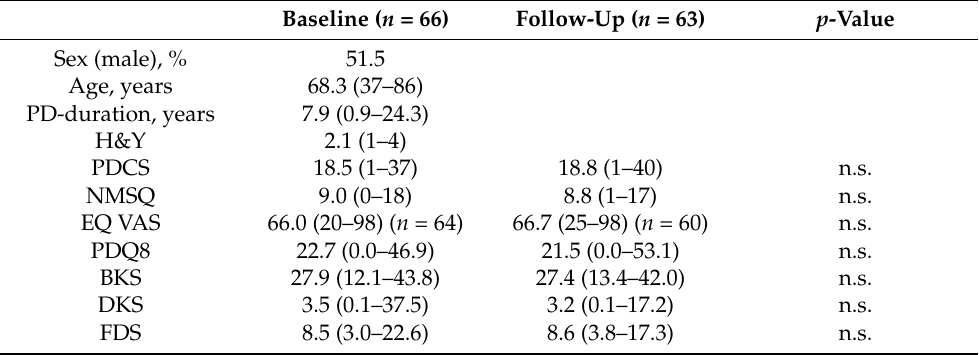
Table 2. Participant characteristics, clinical variables and PKG-data at baseline and follow-up. Results are given in means (min–max). Changes in clinical variables and PKG data were not